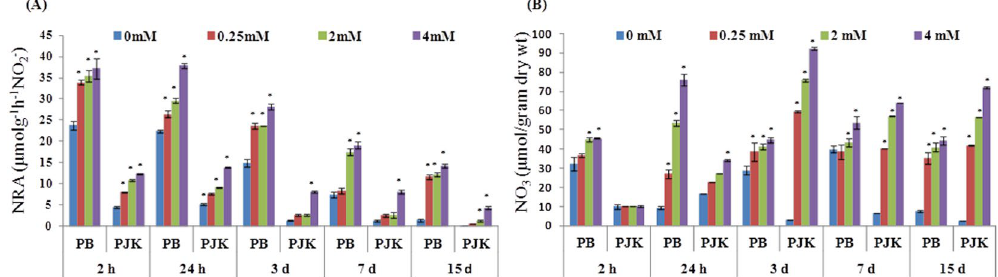
Figure 1. Effect of nitrate concentration on NRA and nitrate content: Leaf nitrate reductase activity (NRA) ( A ) and nitrate content ( B ) was measured in PB and PJK after 2 h, 24 h, 3 d, 7 d and 15 d of various nitrate treatments (0.25 mM KNO 3 , 2 mM KNO 3 and 4 mM KNO 3 ). For control conditions (0 mM KNO 3 ), equal amount of KCl was supplied to the plants. The vertical bars indicate mean ± S.E (n = 3). Asterisk on the top of the bar indicates level of significance ( * p-value < 0.05, student’s